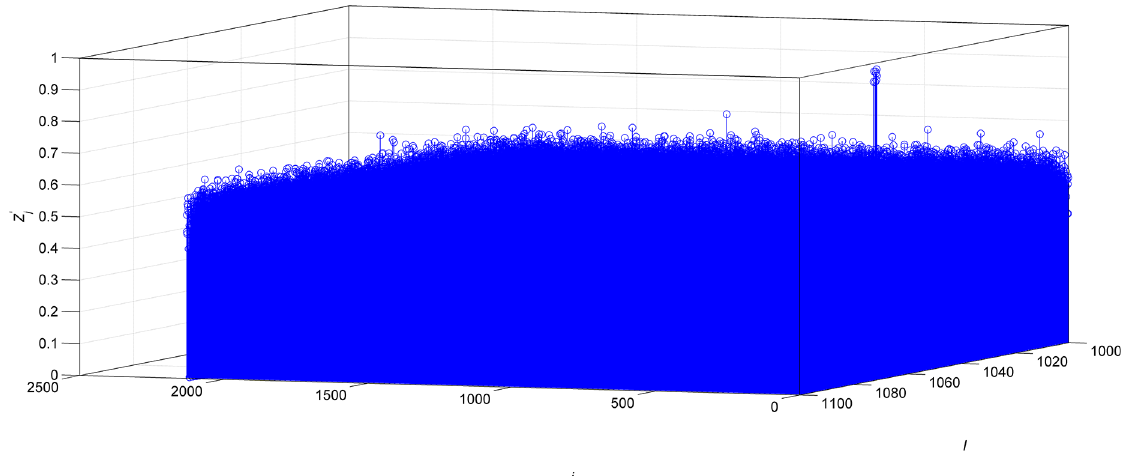
Fig 6. The result of frame length